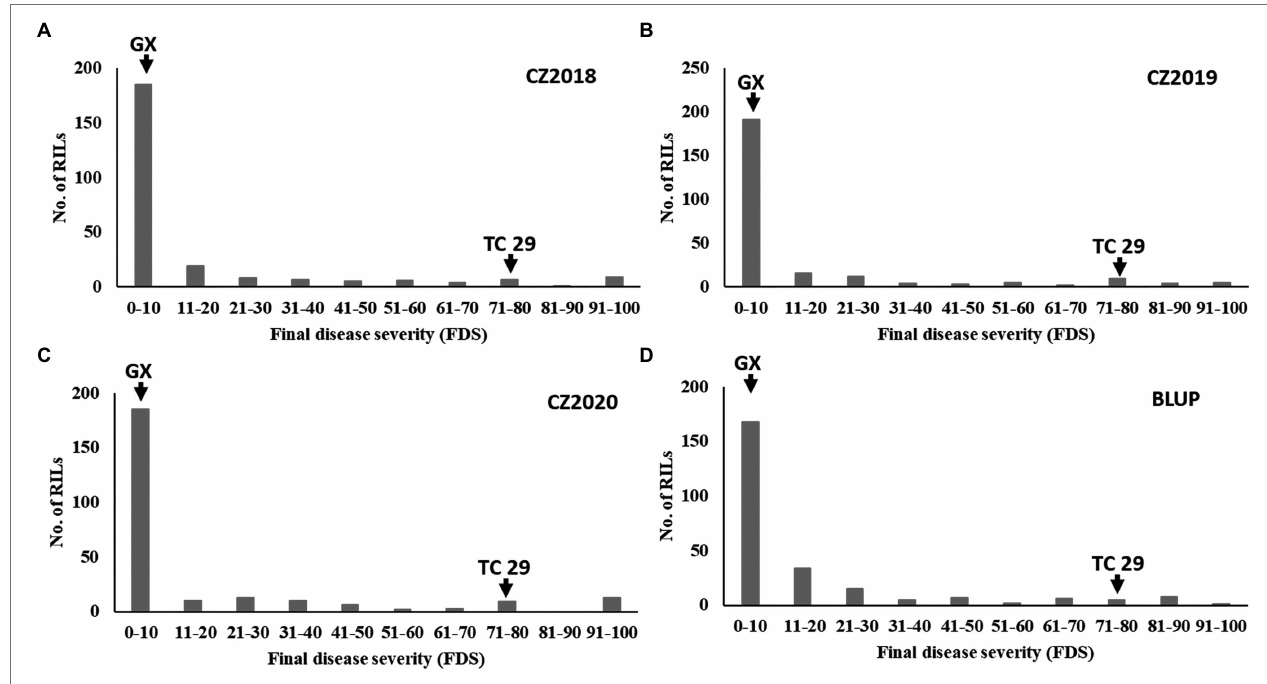
FIGURE 2 | Frequency distributions of the final disease severity (FDS) for the recombinant inbred lines (RILs) population derived from Gaoxianguangtoumai (GX) × Taichung 29 (TC 29) at Chongzhou in 2018 (A) , 2019 (B) , 2020 (C) , and best linear unbiased prediction (BLUP) values (D) .